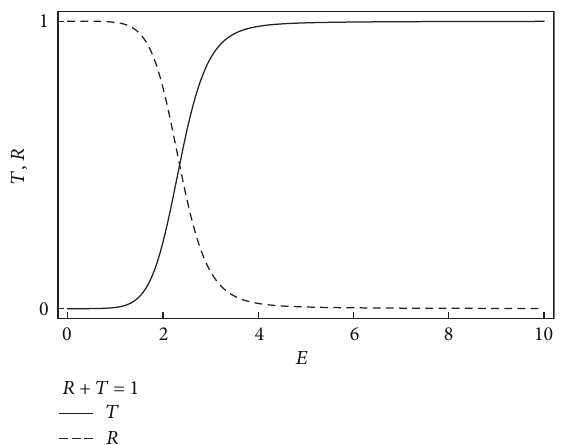
Figure 2: The unitarity condition. The transmission 𝑇 and reflection 𝑅 coefficient for the GAMAR type potential barrier varying with 𝐸 for = ̃𝑥 = 1 , Λ = ̃Λ = 1 , Δ = ̃Δ = 2 , 𝐴 = 4 , 𝐶 = 5 , 𝐵 = 𝐷 = 3 , and 𝑚 = 1 . 𝛼 = 𝛽 = 2 , 𝑥 0 0